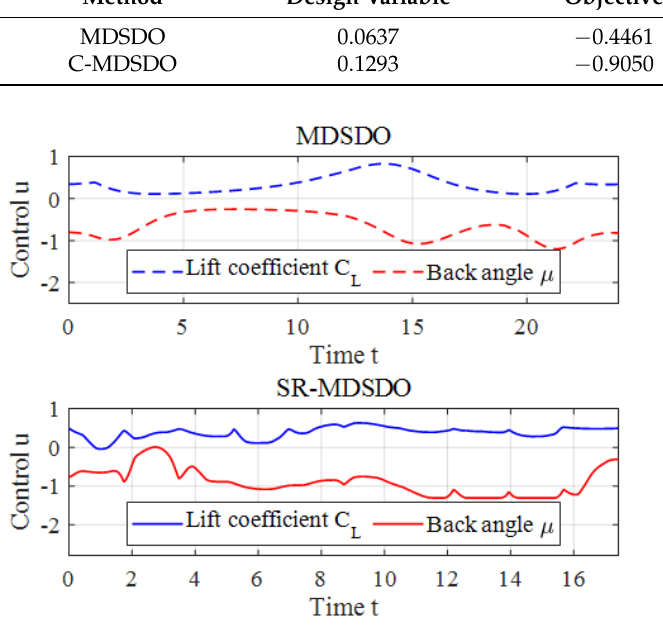
Figure 11. The comparison of control strategies for MDSDO and C-MDSDO. Table 4. The optimization result comparison for MDSDO and C-MDSDO.